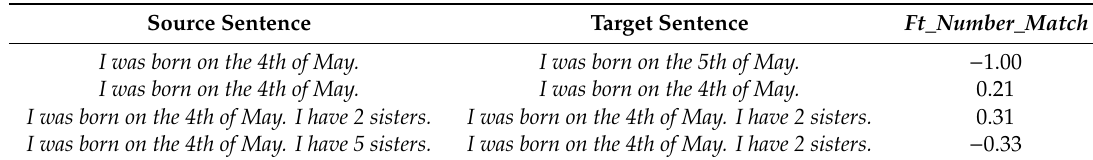
Table A1. Some examples to illustrate calculation of Ft_number_match . Source